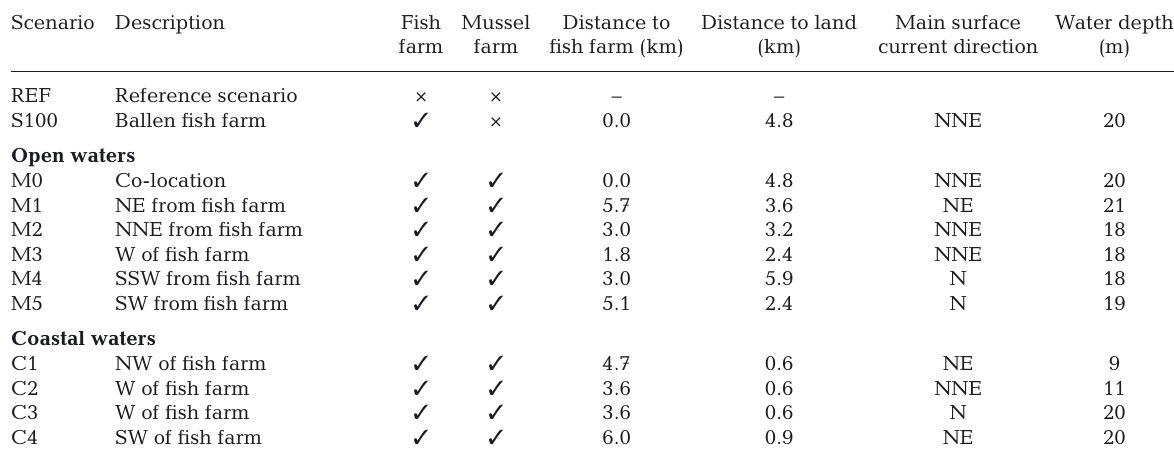
Table 1. Overview of the scenarios with different farm locations indicated with the distance to the fish farm and to nearest land, main current direction and water